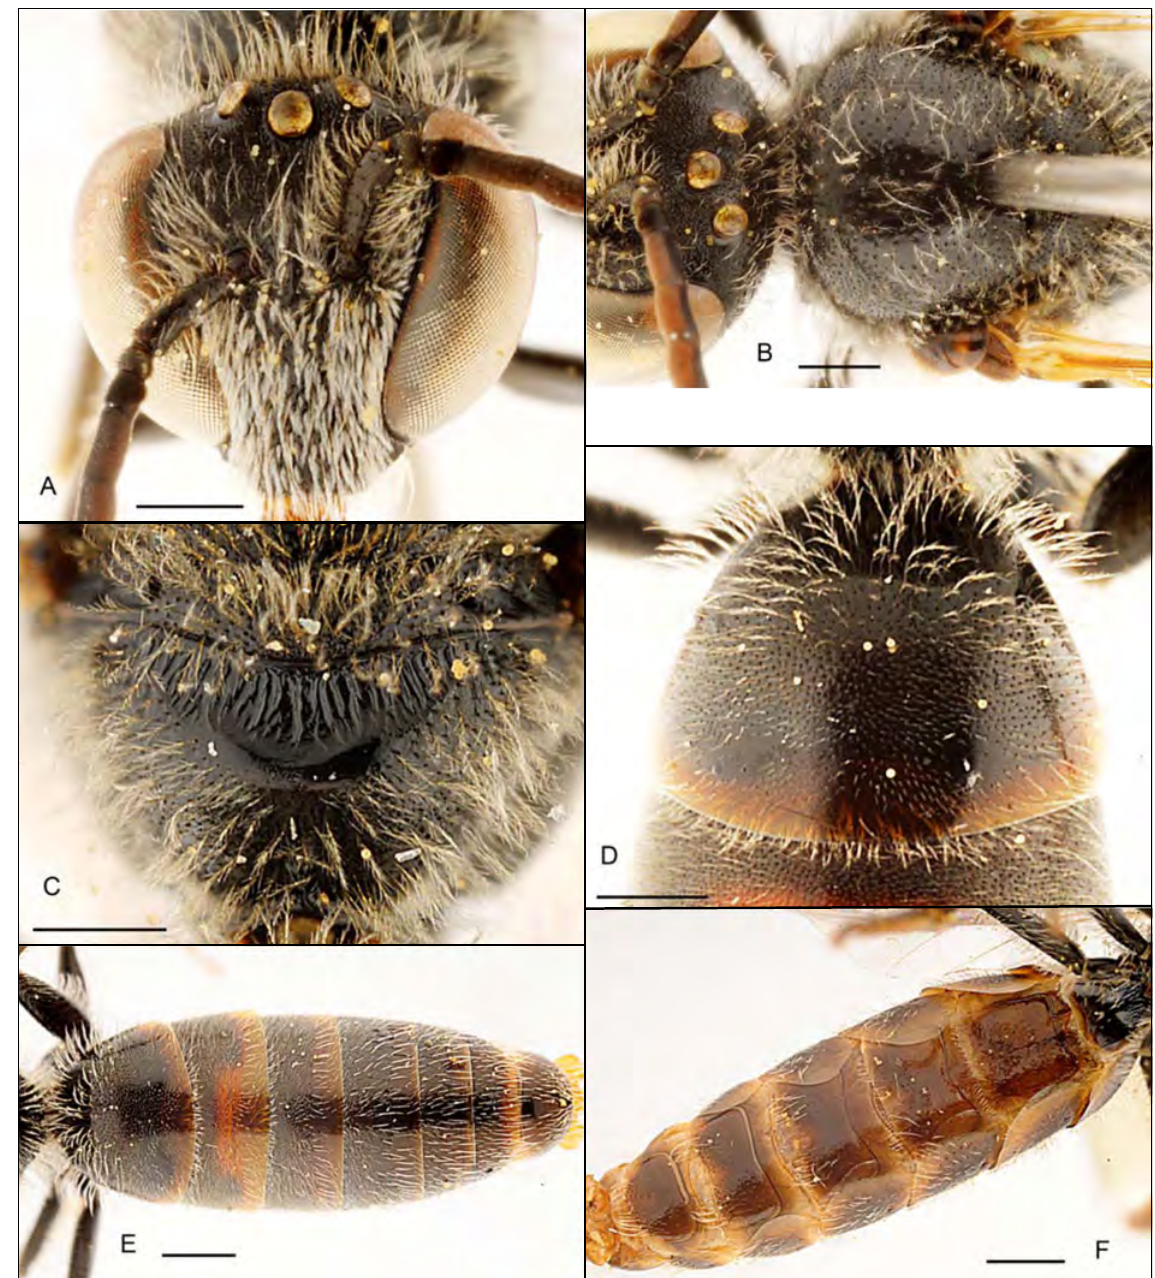
Male Body length 7.5 mm. Wing length 6 mm. Legs very long, especially tarsi (length of posterior tarsi equal to length of mesosoma), totally black to blackish brown except foretarsi yellowish brown (Figs 12A, 13A, 14A-B) (all tarsi yellowish in L. hantamense and L. tigrinum ). Metapostnotum with longitudinal ridges. Dorsolateral slopes of propodeum shining, punctate. Punctation of mesoscutum sparse between